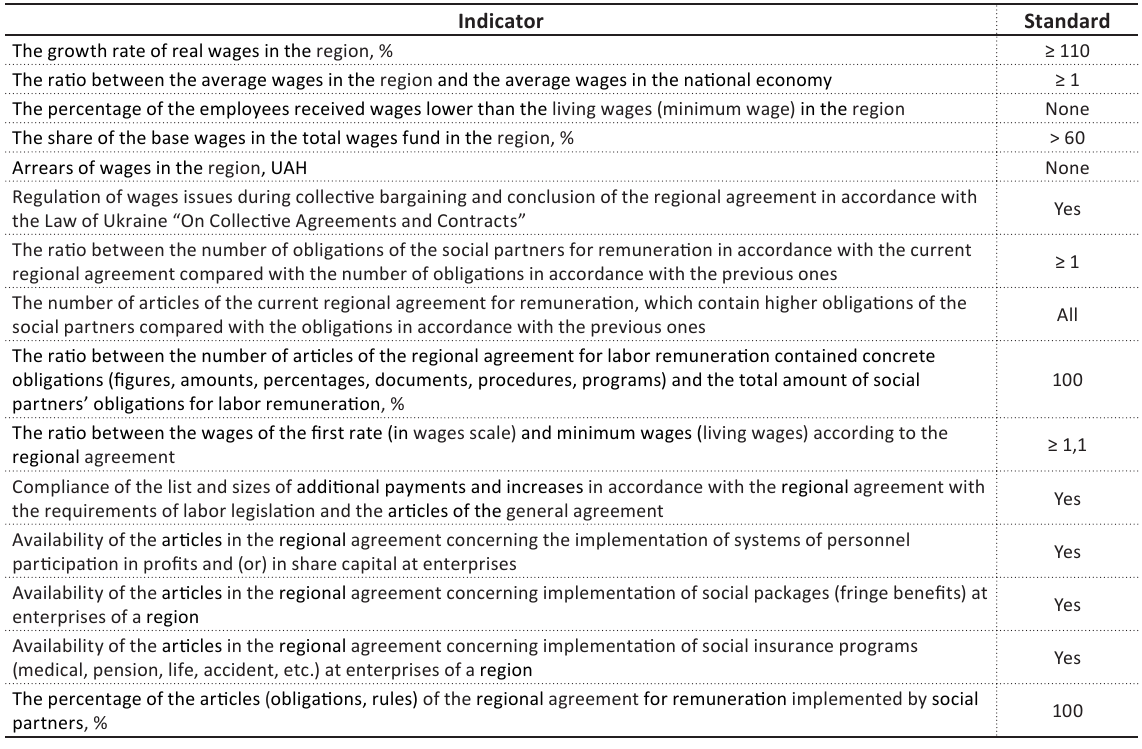
Source: Constructed by the authors.